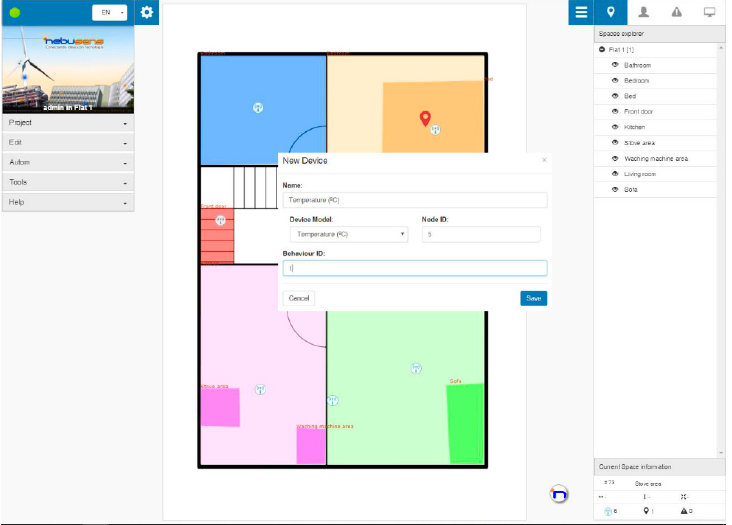
Figure 3. CAFCLA implements tools, which, among other functions, define the areas of activity identification and configure